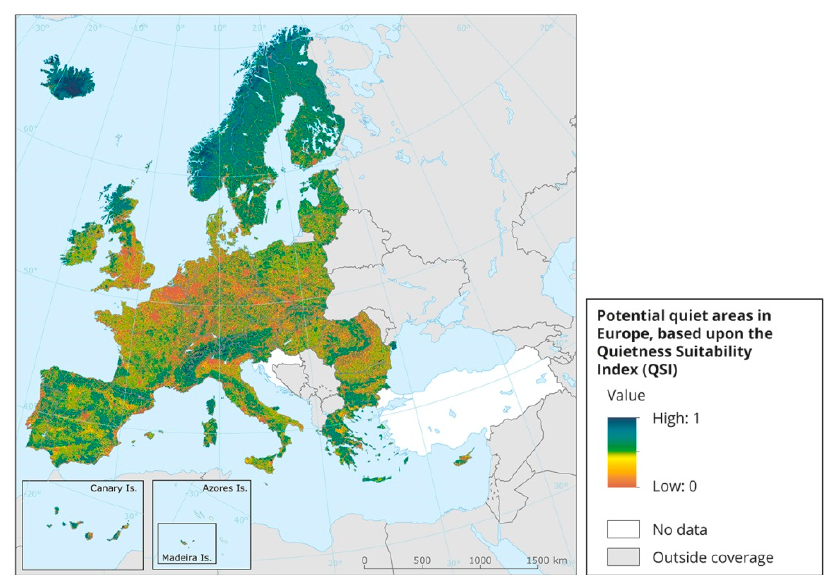
Figure 7. Map of Europe created using the Quietness Suitability Index (QSI), where the potential for quiet areas is based on noise data and land use. Map previously published by the European Environmental Agency [25].